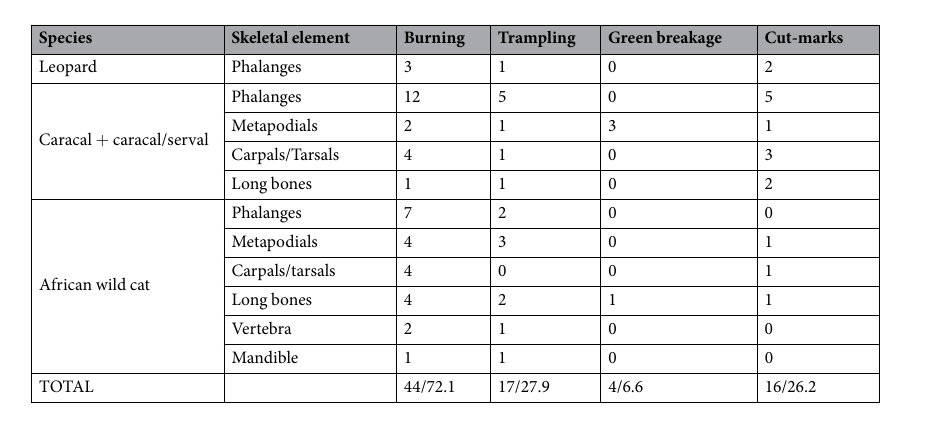
Table 3. Human-induced bone damage and surface modifications (data in NISP and